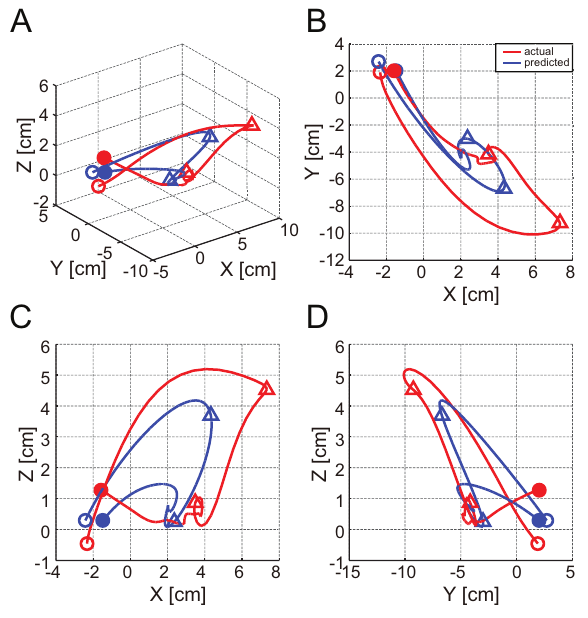
Figure 5. Decoding results for monkey B in three dimensional space. A) Example of 3D hand trajectory prediction for one trial movement using 32 channel ECoG signals. The predicted and observed trajectories in 3D space are depicted in blue and red, respectively. The unfilled circles represent the start point of movement. The two triangles mark hand position at equivalent time points during movement. Solid circles denote the end point of movement. B, C, and D) The predicted (blue) and observed (red) trajectories shown in the X–Y, X–Z, and Y–Z planes, respectively.